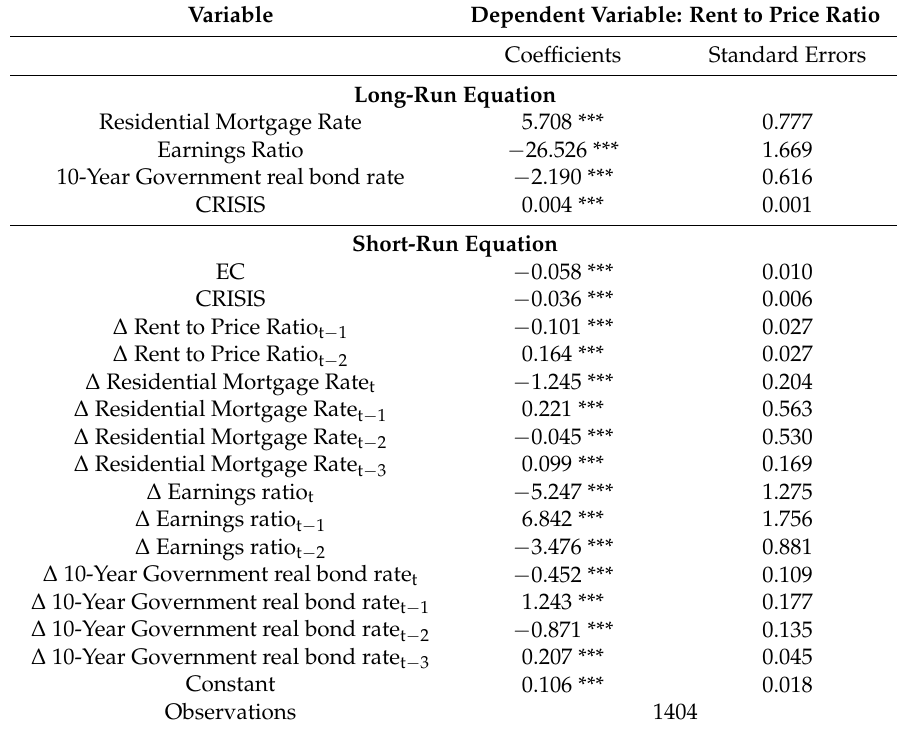
Table 5. Pooled Mean Group Results with CRISIS dummy based on Model